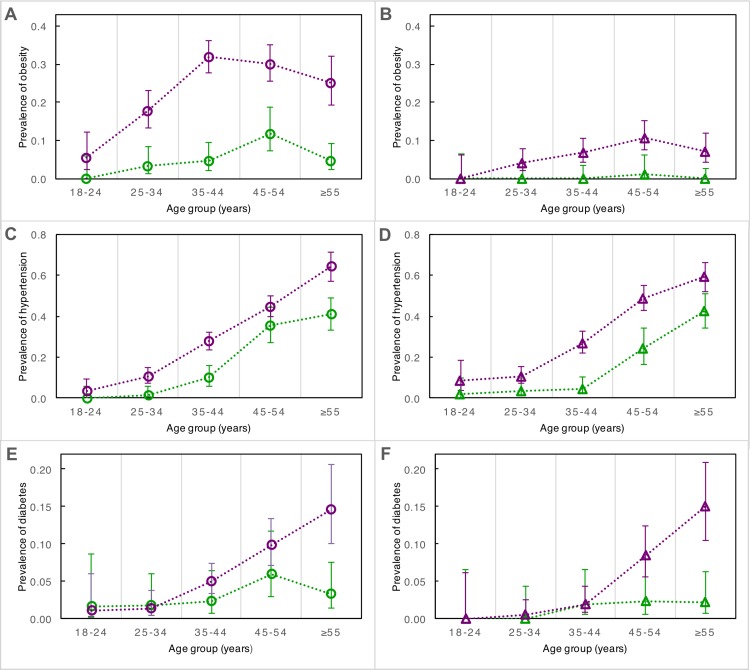
Prevalence by age group of obesity, hypertension, and diabetes in urban and rural men and women from Brong Ahafo, Ghana.In the left panels (A), (C), and (E), prevalence by age group is depicted for urban females (purple circles) and rural females (green circles). In the right panels (B), (D), and (F), prevalence by age group is depicted for urban males (purple triangles) and rural males (green triangles). Error bars denote 95% confidence intervals of estimates.